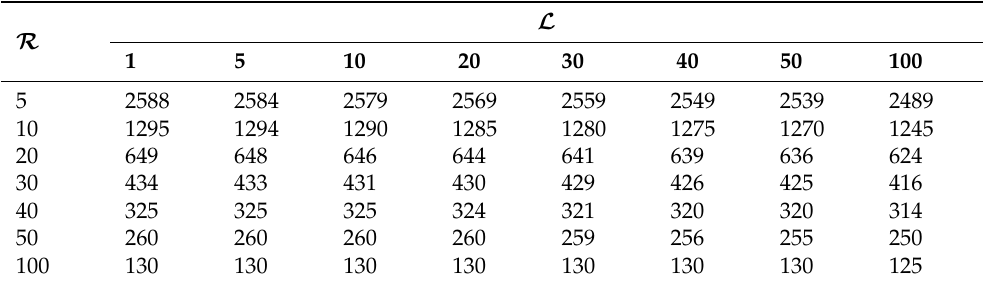
Table 2. Amount of images that remain after the sub-imaging construction, taking all runs in Class A as an example, for several possible configurations of sub-image